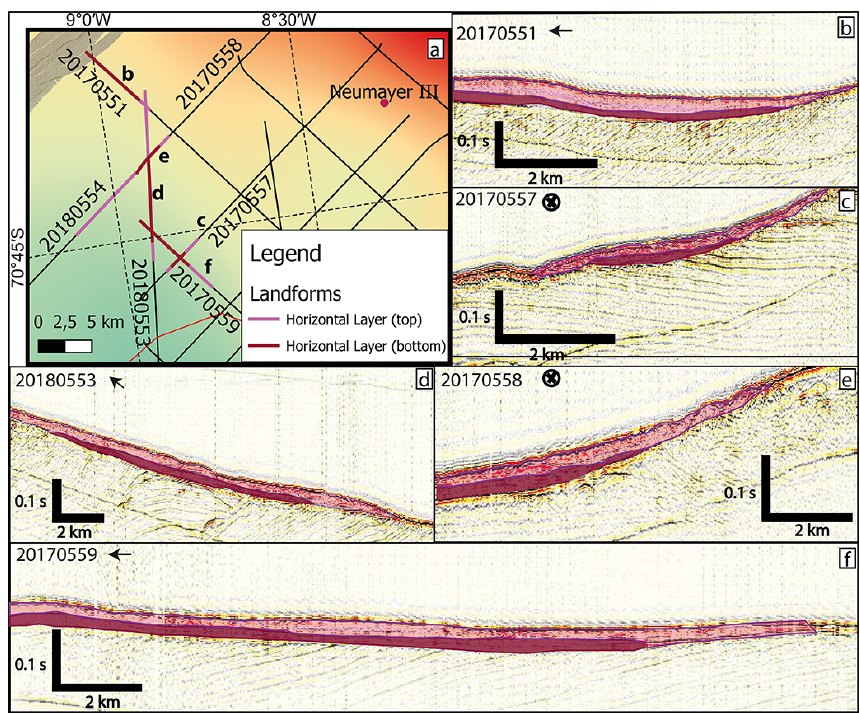
Figure 5. Panel (a) gives an overview of the location of the sea-floor-parallel seismic unit. Panels (b) – (f) show the extent of the unit in the trough mouth. The dark pink represents the bottom layer and the light pink the layer on top. The direction of the current ice flow is indicated as in Fig. 4. The colour scale in (a) represents the depth below sea level as in Fig.